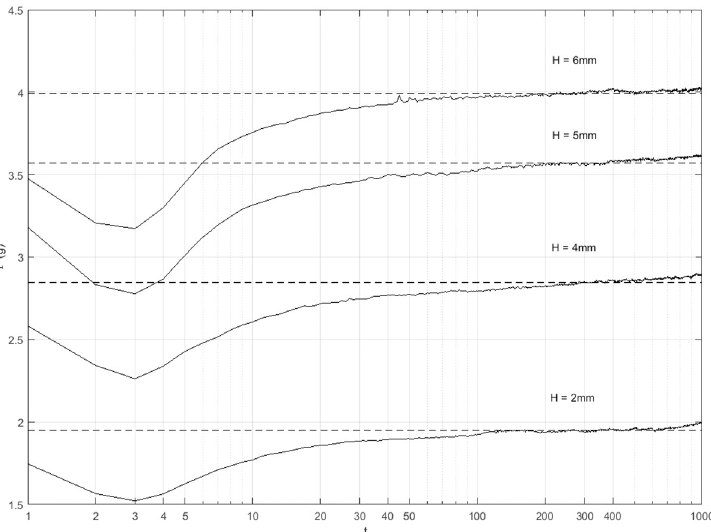
Fig 6. The temporal evolution of the intensity. The acceleration signal was measured by the accelerometer connected with the cylindrical container at the sampling frequency of 3.2 kHz. The raw data was low-pass filtered with the cutoff frequency of 50 Hz before the peak values were